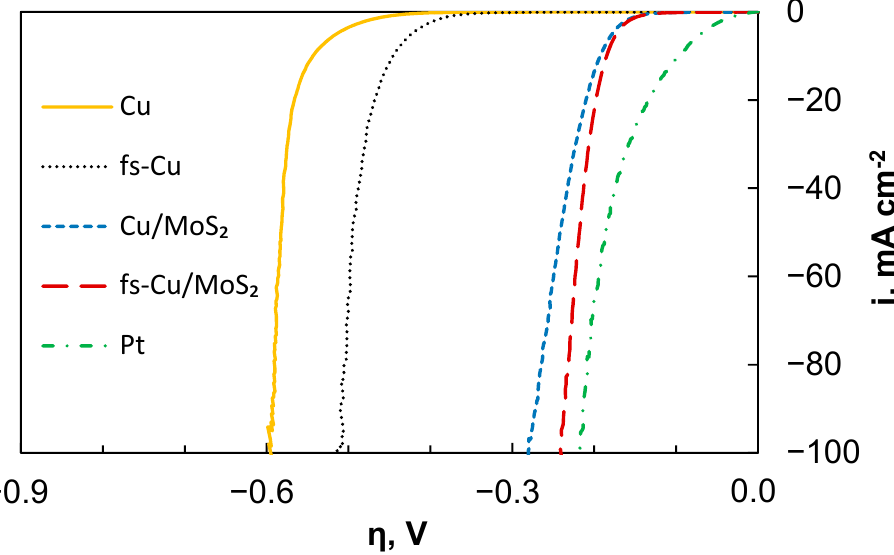
Figure 3. The LSV curves showing the HER electrocatalytic activity of the unmodified and modified copper substrates as well as the respective substrates coated in an electrochemically deposited MoS 2 film. Scan rate—2 mV s − 1 , 0.5 M H 2 SO 4 electrolyte. Corrected for iR-drop.